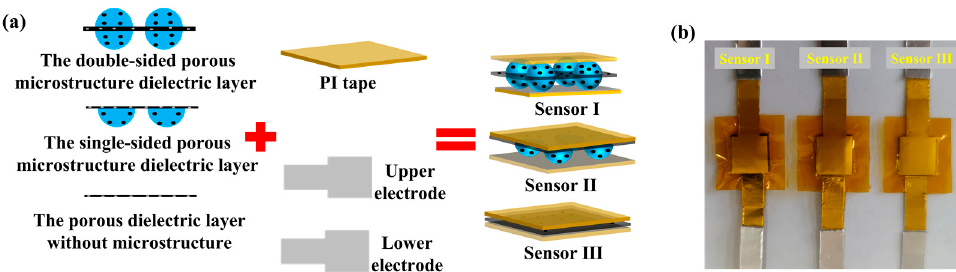
Figure 4. Sensor packaging of the sensor I, the sensor II and the sensor III. ( a ) The packaging process; ( b ) the actual image.